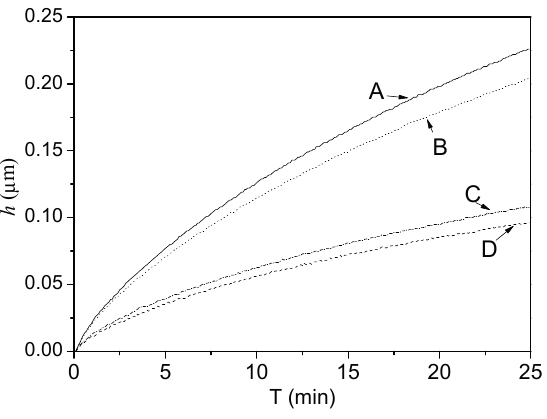
Figure 4. Load-displacement curves of GNS-based epoxy resin coating with different contents of (A) 0; (B) 0.1 wt %; (C) 0.4 wt %; and (D) 0.7 wt